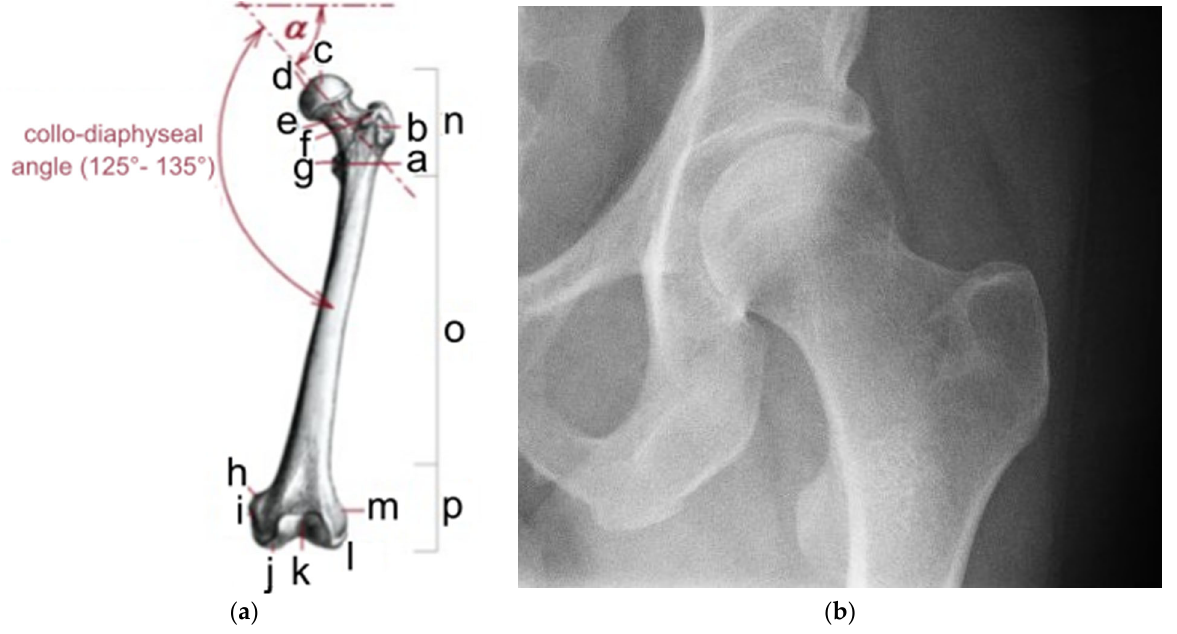
Figure 1. ( a ) Anatomy of femur bone (a—linia intertrochanterica; b—trochanter major; c—caput